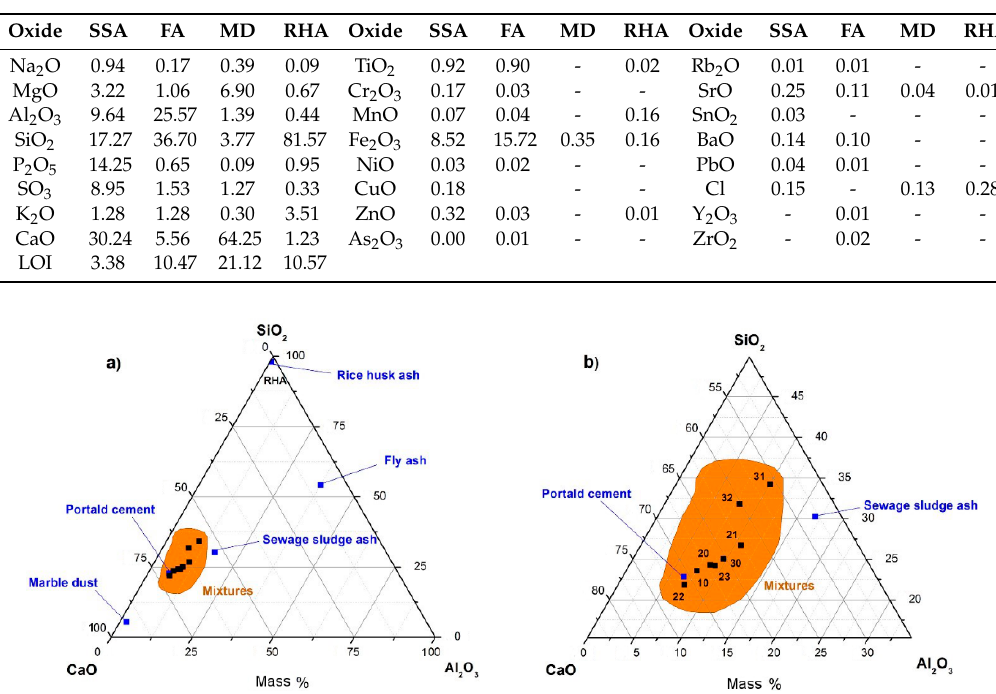
Table 3. Chemical composition (oxides, in %) for the mineral additions used.